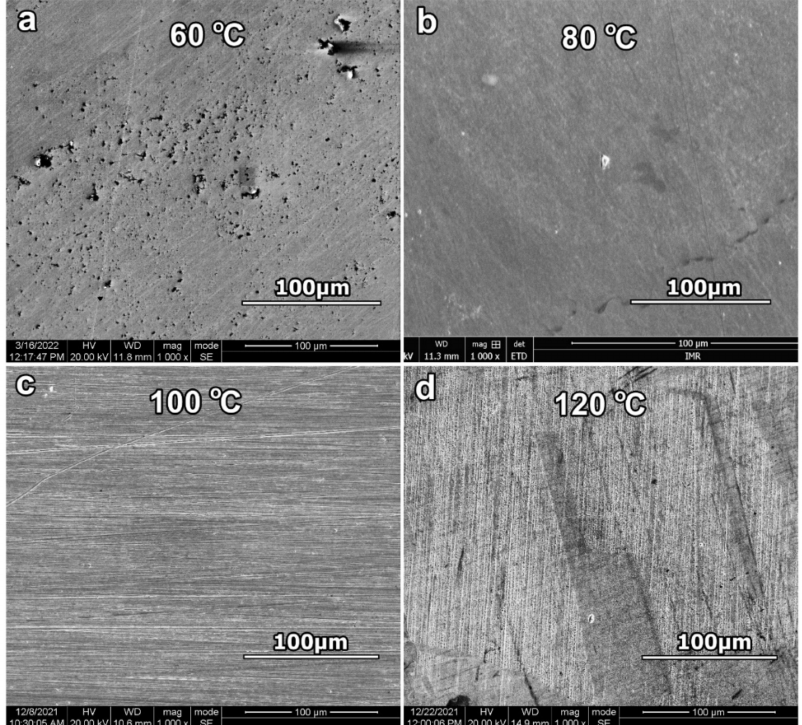
Figure 11. Morphologies of 304L stainless steel after corrosion in nitric acid vapor phase at